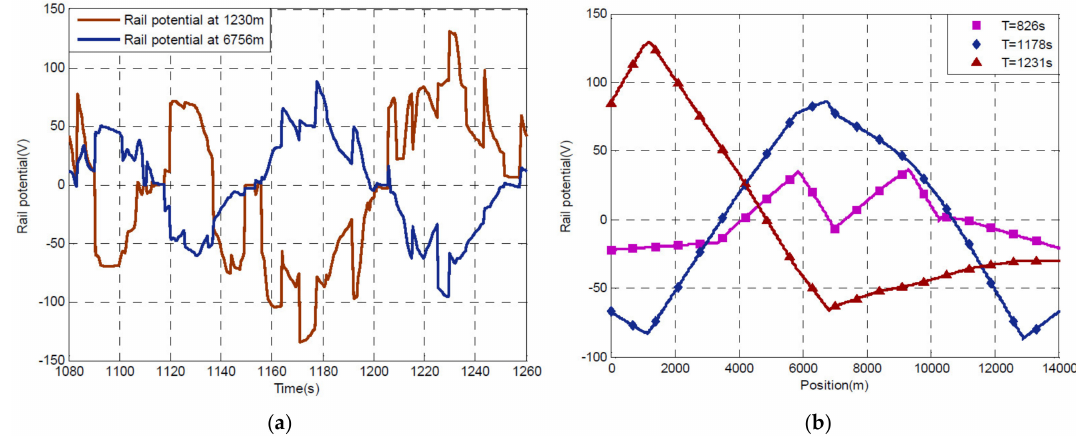
Figure 5. Example of track voltage variability vs. time ( a ) and position along the track ( b ). Reproduced from